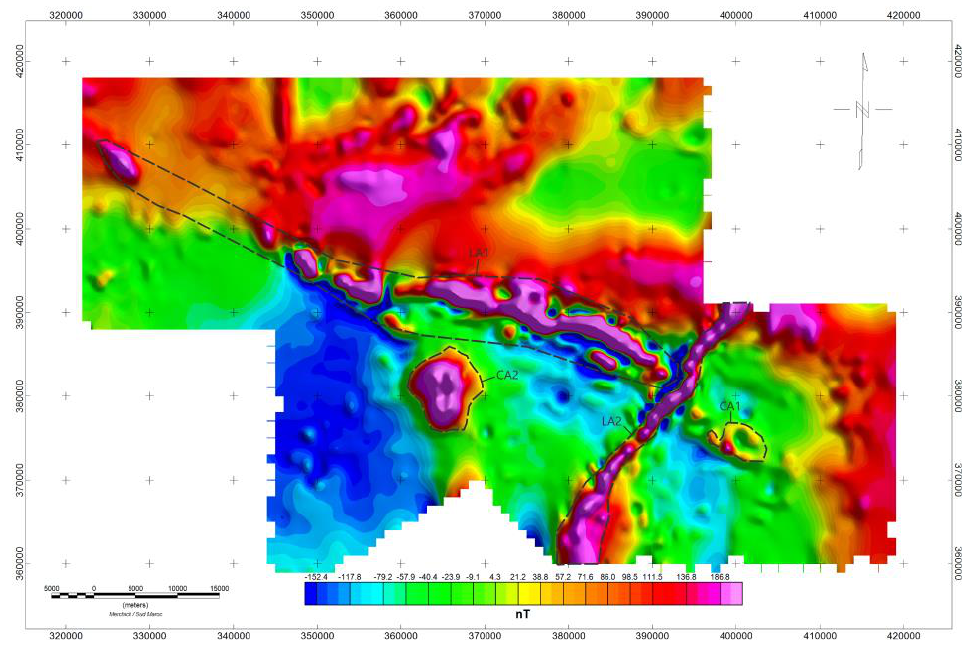
Figure 12. Residual magnetic anomaly map of Bou Azzer inlier and adjacent regions reduced to the magnetic pole.